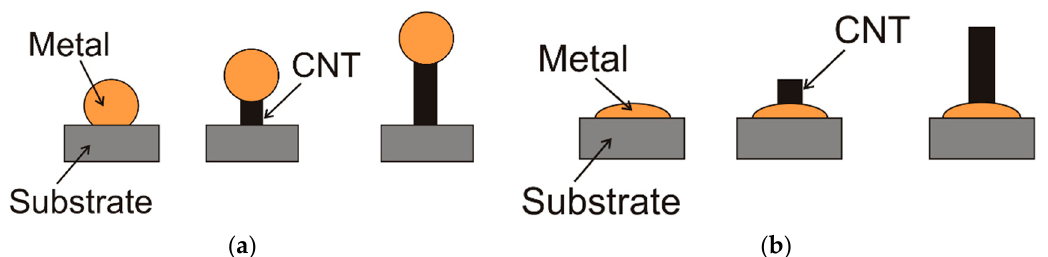
Figure 7. Scanning electron microscopy (SEM) images of ( a ) As ‐ received, ( b ) Carbon nanotube (CNT)10, ( c ) CNT30 and ( d ) CNT60.